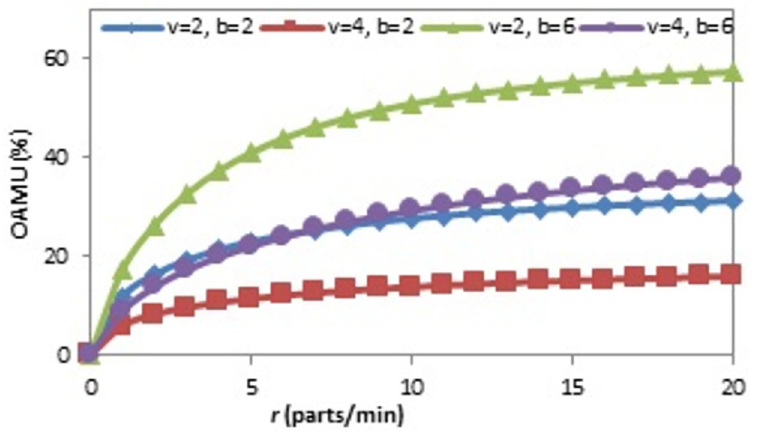
Fig 14. OAMU-r diagram for triple-machine